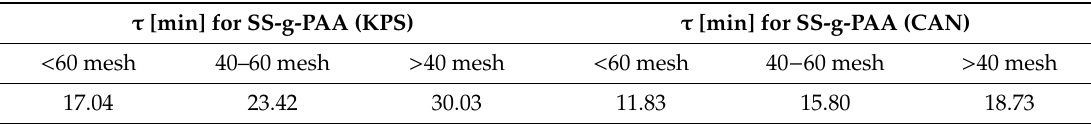
Table 4. The rate parameters for superabsorbent with di ff erent particle